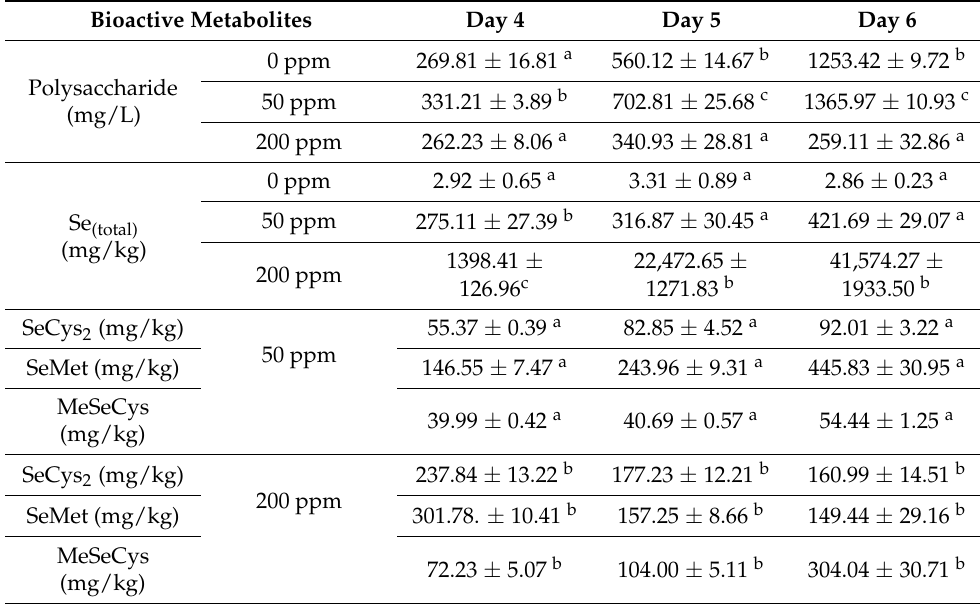
Table 2. Polysaccharide, total Se content, and selenoamino acids in Ganoderma lucidum. Bioactive